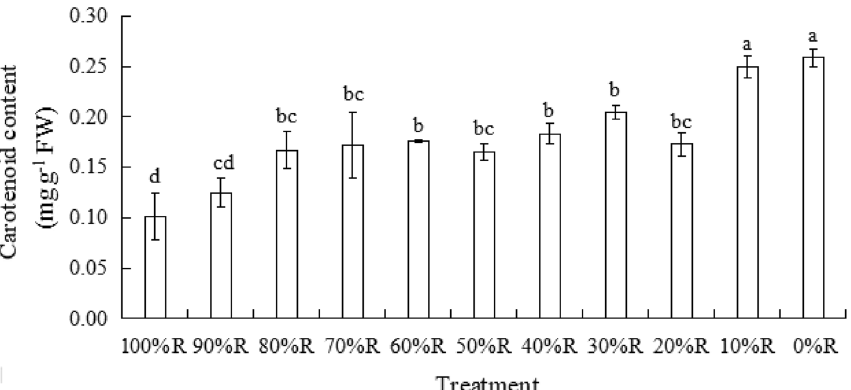
Figure 5. Carotenoid (Car) content of plants grown under different light treatments (at harvest). Different letters for the same parameter indicate significant differences at the 5% level, according to the Tukey’s test (n = 3). The bars represent the standard errors.